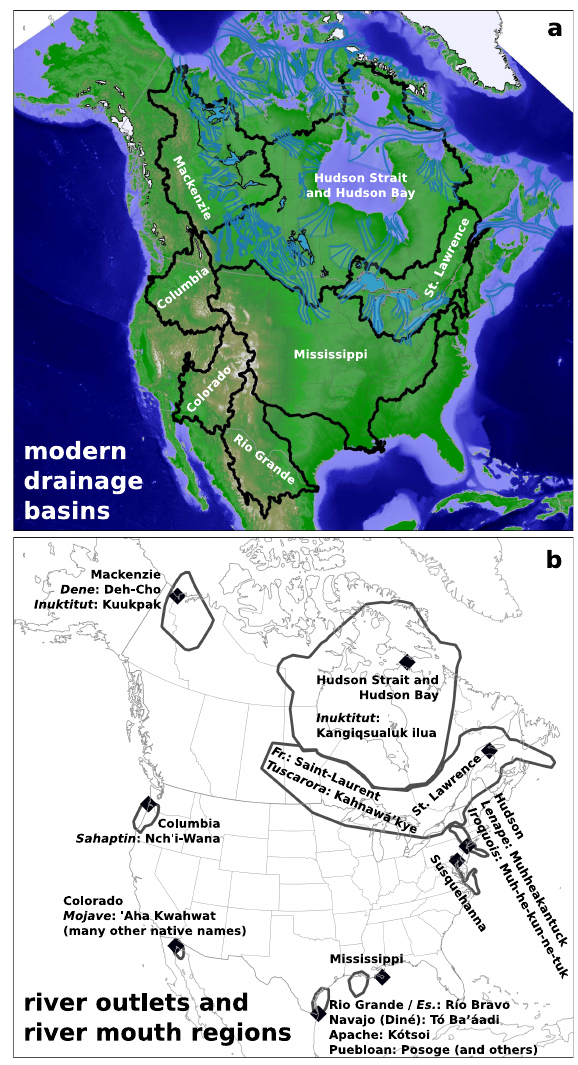
Figure 5. Modern drainage systems and river mouth regions used to reconstruct past drainage basins. (a) Modern drainage basin extents for the rivers involved in this study, with ice and lake extents from the 1ka time step of the maps of Dyke (2004), elevation basemap from GEBCO_08 (British Oceanographic Data Centre, 2010), and modern drainage basins from Lehner et al. (2013). (b) Modern river mouths alongside the river mouth regions used to define a flow path as part of a named drainage basin (Sect. 2.5). Names are also given in European non-English languages where they are common, along- side a non-exhaustive set of common names in local languages. Note that the mouth of the Mississippi River lies entirely outside its river mouth region. This is because the topographically routed flow, computed using the Metz et al. (2011) r.watershed algorithm, follows the course of the Atchafalaya River; the present path of the Mississippi near its mouth does not follow the regional topographic gradient because it is held in its old course by the Old River Control Structure (see Harmar and Clifford, 2007). These same river mouth regions are used for all time steps in all